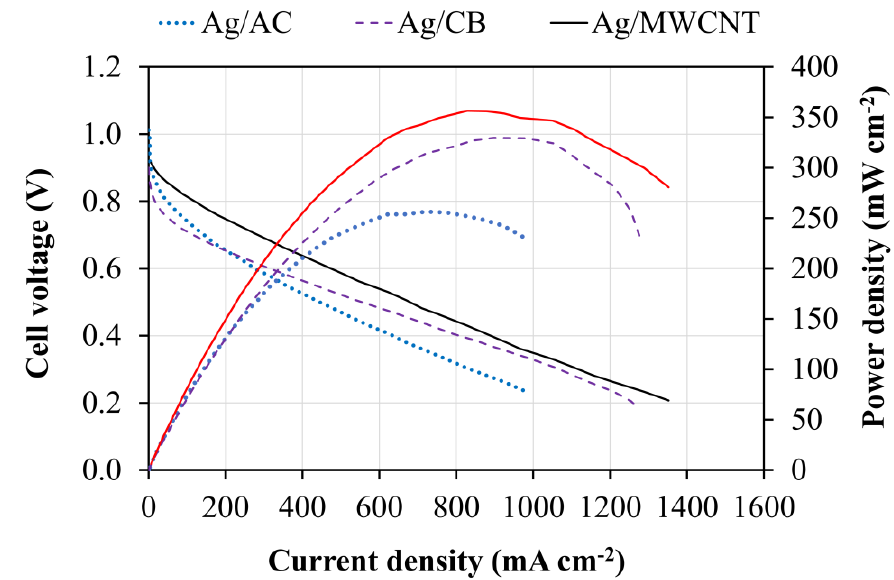
Figure 8. Anion exchange membrane fuel cell (AEMFC) performance using Ag / AC, Ag / CB, or Ag / MWCNT as the cathode catalyst.